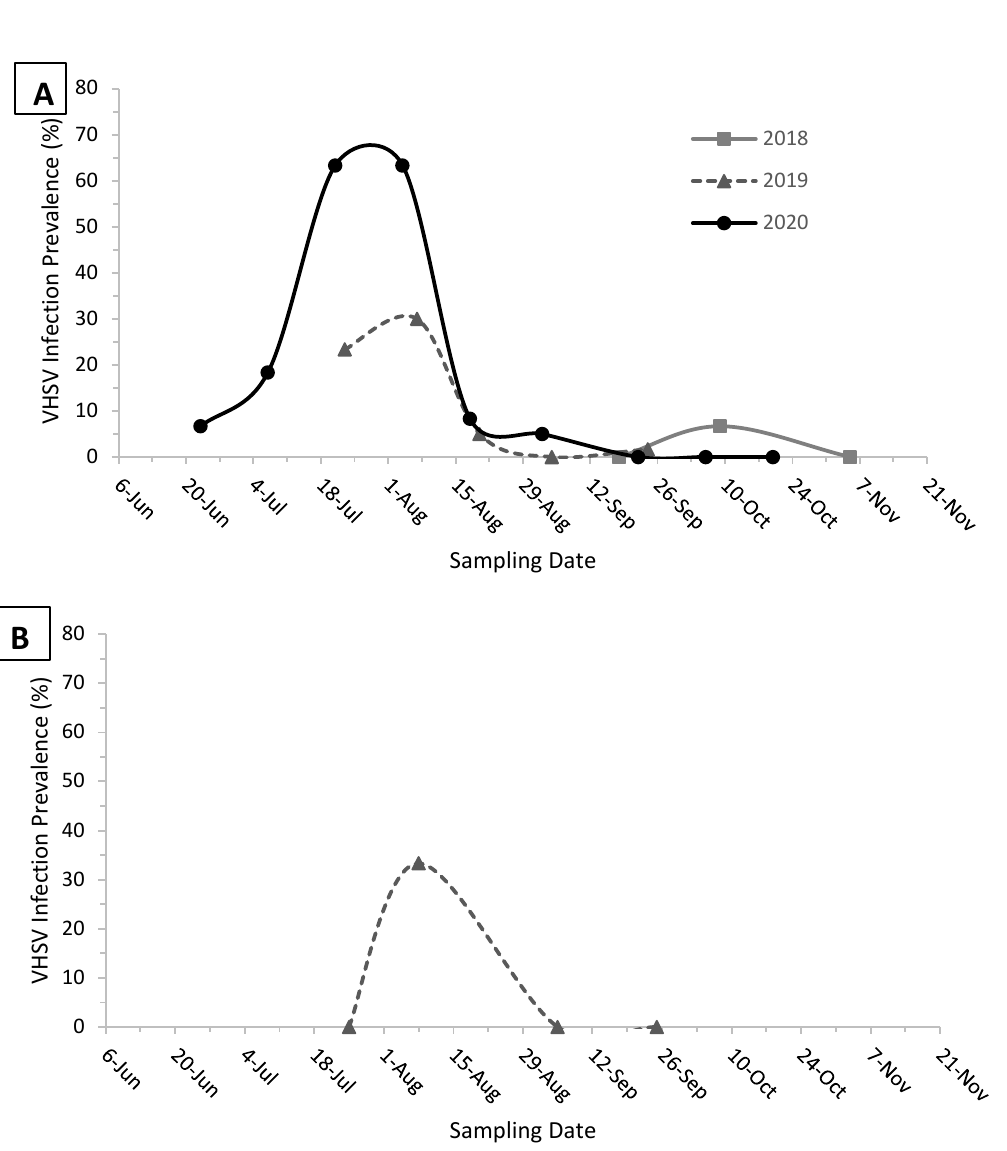
Figure 1. Progression of VHS virus epizootics in age 0 Pacific herring C. pallasii from the Puget Sound, WA region, including ( A ) Port Angeles Harbor (2018–2020) and ( B ) Port Ludlow Harbor (2019). Each data point reflects n = 30–60 fish.